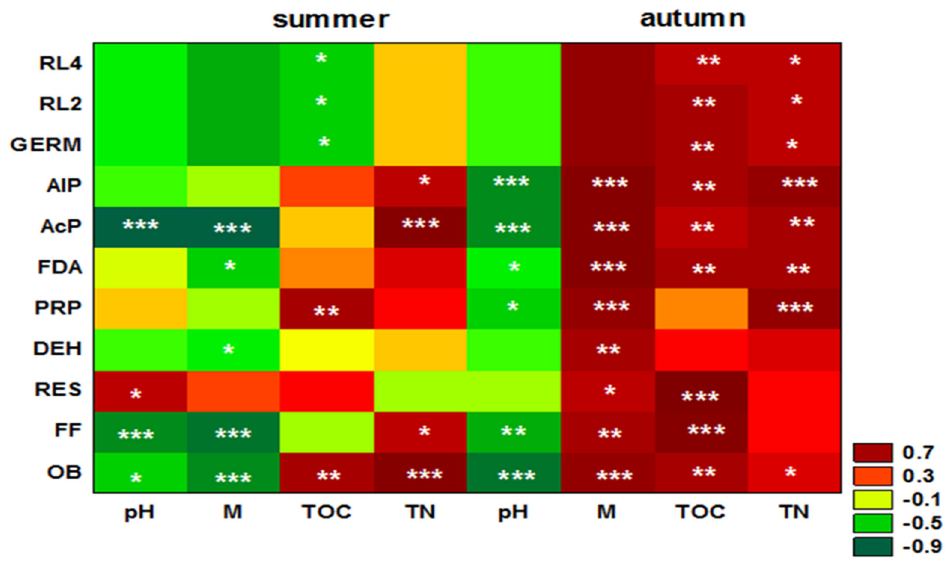
Figure 9. Heat map displaying the Pearson correlation coefficients between chemical and physico-chemical properties; microbial, biochemical and enzymatic activity; and phytotoxic parameters at the level of the seasonal variability. Significant at * p < 0.05; ** p < 0.01; *** p < 0.001, respectively.